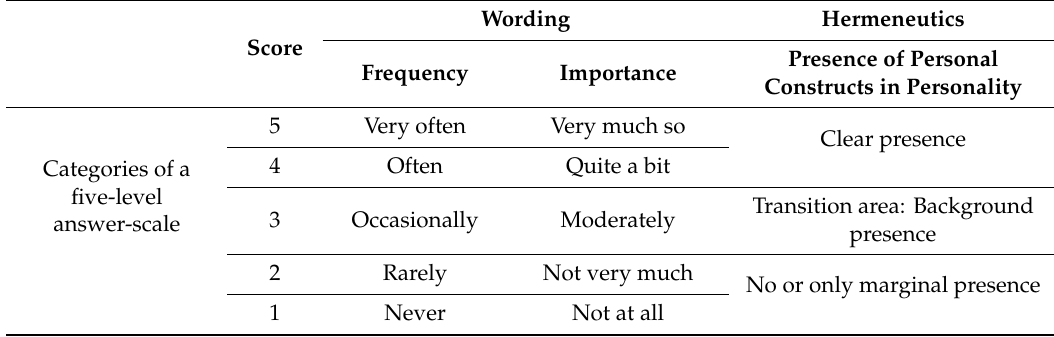
Table 3. Hermeneutics of the wording a five-level answer scale. (Huber and Huber 2012, p.